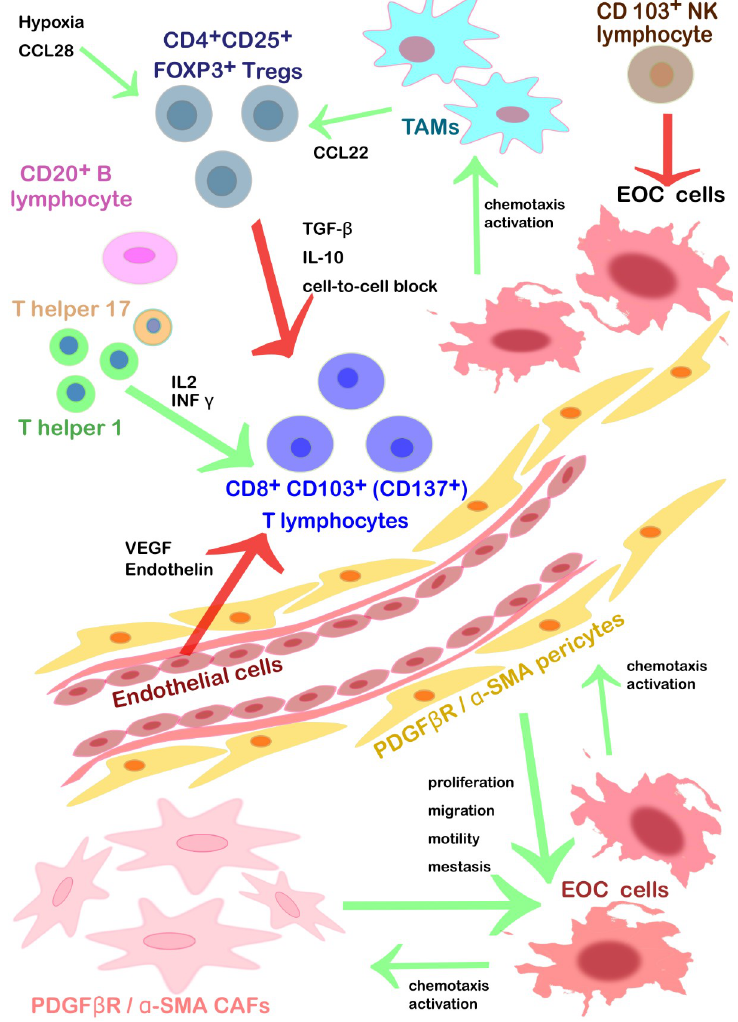
Figure 2. The main cell types that populate the EOC’s TME: overall functions and cross-talks. Within EOC’s tumoral islets, the stroma holds a variety of cell types, such as CAFs and α-SMA+ pericytes. CAFs are recruited by PDGFβ and they promote EOC cells’ motility, overgrowth, neo-angiogenesis, and invasion. α-SMA+ pericytes are recruited by the PDGFβ and they reduce EOC cell-to-cell adhesion without affecting angiogenesis significantly unless providing guide-sheets for endothelial cells during neo-angiogenesis. Their rate and genetic signature correlate with proliferation, migration and cell motility of EOC. CAFs, α-SMA+ pericytes and EOC cells communicate via a mutual cross-talk that creates a vicious cycle towards cancer progression. TILs include CD 103+ NK lymphocytes, T helper 1 lymphocyte, T helper 17 lymphocytes, CD8+ CD103+ (CD137+) lymphocytes. Monocytes from the bloodstream are chemoattracted by cancer cells and become resident TAMs, activated by IL10, IL6, TGFβ, PUFAs and they play a key role in the EOC’s biology (see Figure 1). Among TILs, there are CD103 + NK lymphocytes that kill EOC cells expressing NKG2DLs. CD8 + CD103 + (also CD137 + in most cases) cytotoxic T lymphocytes need to be activated by T helper lymphocytes (type 1 or 17) under the trigger of INF γ and IL-2 to chase after cancer cells and to attack them as e ff ector T cells. Resident CD20 + B cells cohabitate with e ff ector T cells and they probably help them as APCs preventing their anergy. The diapedesis of this TILs is inhibited by endothelin and VEGF mainly from the endothelium. Among TILs, there are also CD4 + CD25 + FOXP3 + T regs that are activated by CCL28 under hypoxia condition and in the presence of B7H4 + TAMs. They inhibit the cytotoxic functions of T cells e ff ectors releasing inhibitory cytokines (TGF- β and IL-10) or via a direct cell-to-cell block. The green arrows stand for positive stimuli , whereas the red ones represent an inhibition towards the pointed